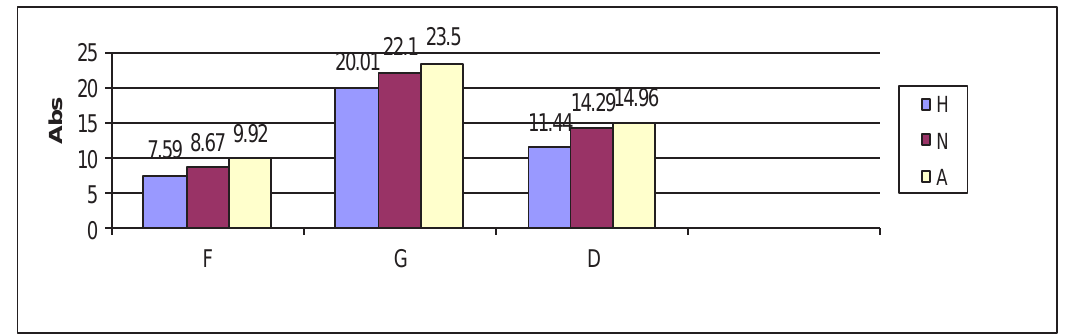
Fig. 1. The characteristic of motor skills in students of different somatotypes: H – hypersthenics; S – sthenics; A – asthenics; F – hang on horizontal bar; G – set-up; D – forward bend; Abs – absolute number.